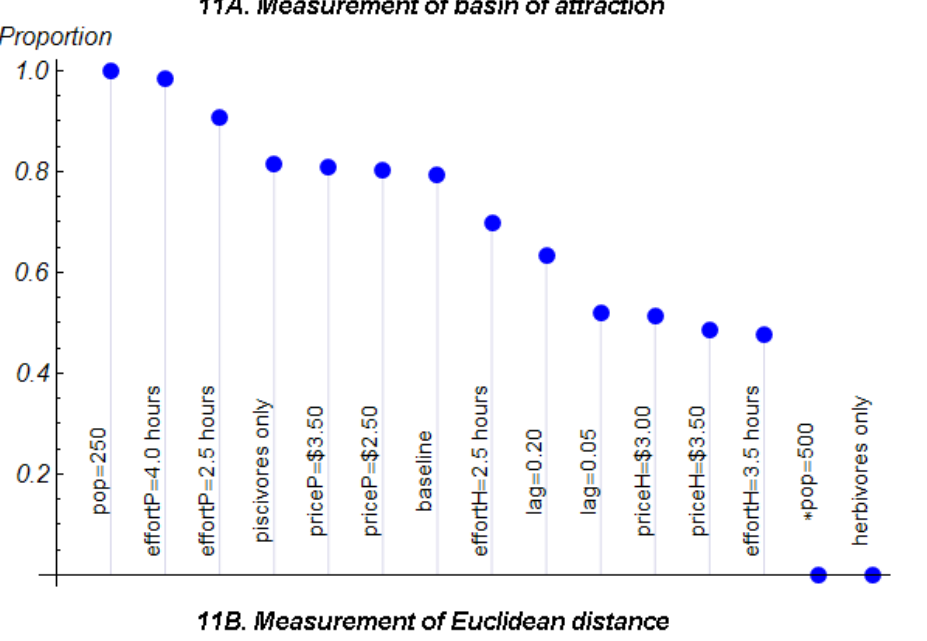
Fig. 11 . Alternate measures of resilience: the proportion of the plane space of the coral/algae phase in the basin of attraction of the coral-dominated state (11A) and the minimum Euclidean distance between the coral-dominated equilibrium state and the boundary of its basin of attraction (11B). At a population of 500, there is no coral-dominated state. Instead, there is an algae-dominated state and a state characterized by stable limit cycles. In this case, the Euclidean distance is a measure from the stationary state of the stable limit